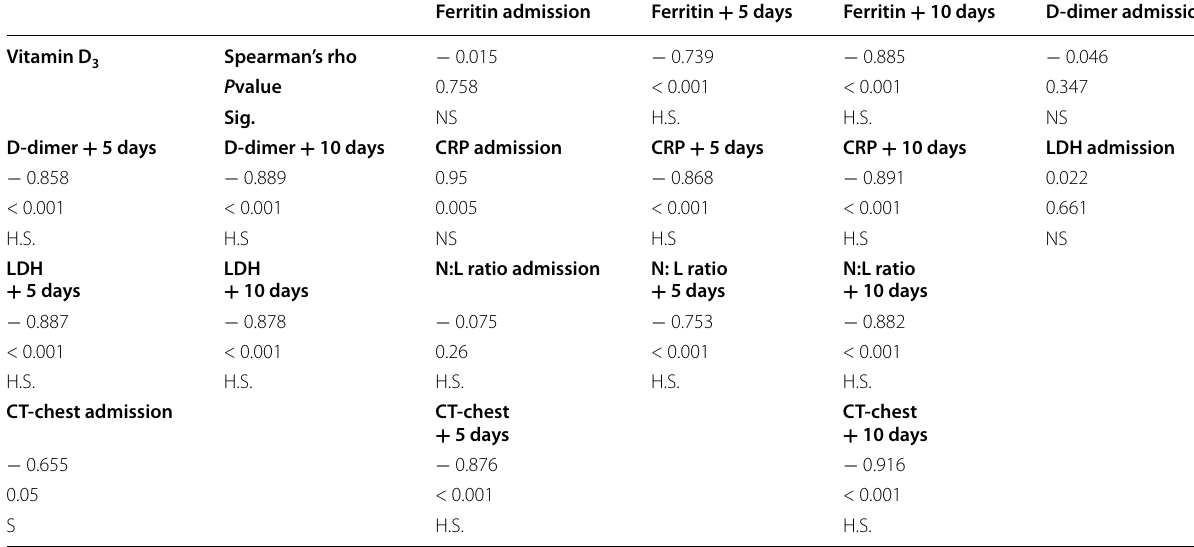
, laboratory investigations and chest computed tomography 3